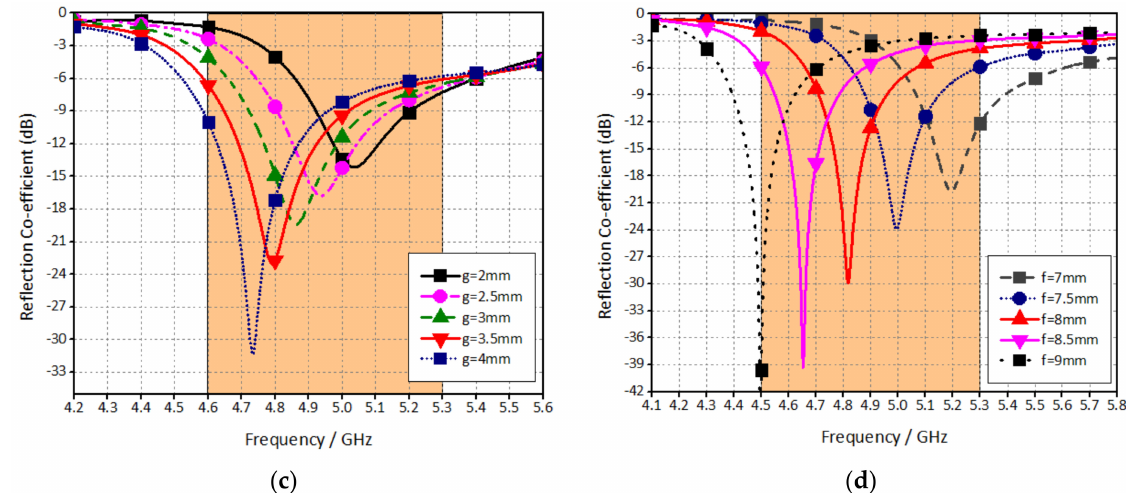
Figure 2. Parametric modelling with respect to ( a ) h ( b ) i ( c ) g ( d ) h.